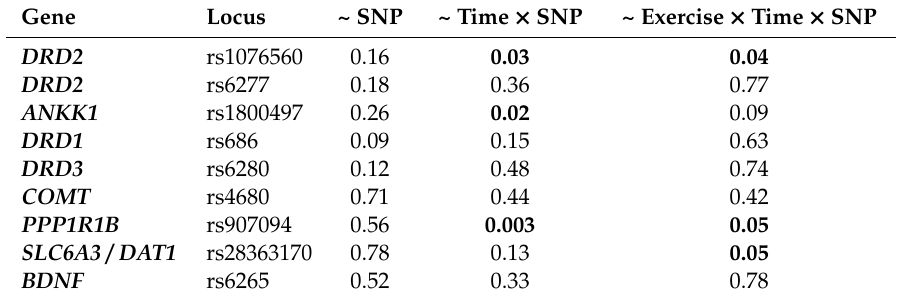
Table 1. E ff ects of ‘SNP’ main e ff ect, ‘Time × SNP’ and ‘Exercise × Time × SNP’ interactions extracted from linear mixed e ff ect model (LMM) analyses. p -values are computed using Satterthwaite’s method employed in the lmerTest R-package. SNP: single nucleotide polymorphism. Bold numbers denote significant main e ff ects and interactions.